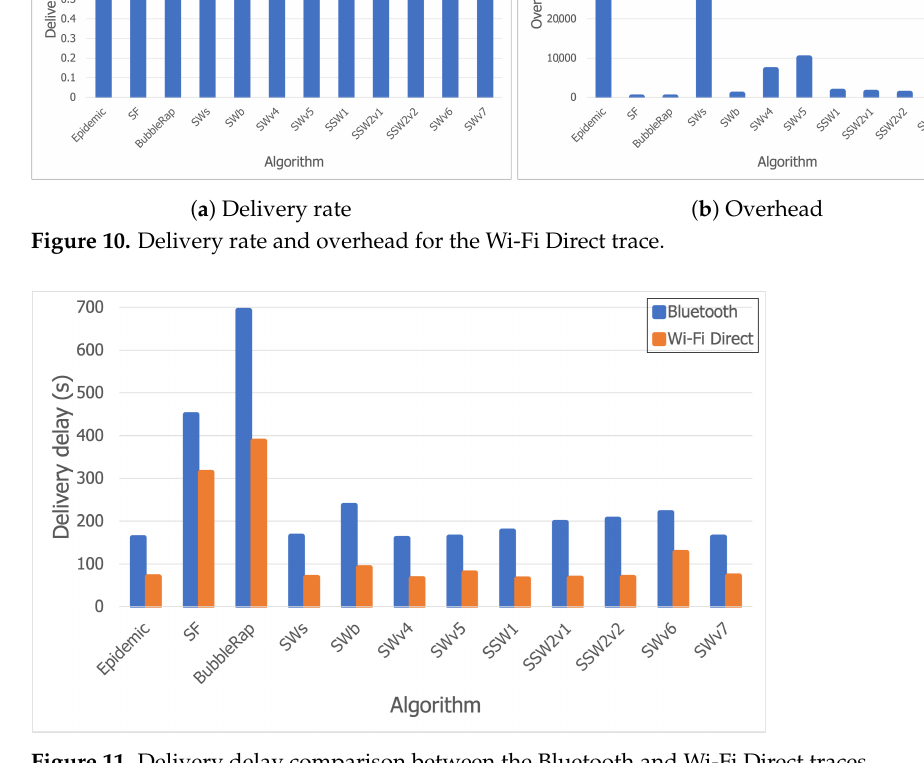
Figure 11. Delivery delay comparison between the Bluetooth and Wi-Fi Direct traces.